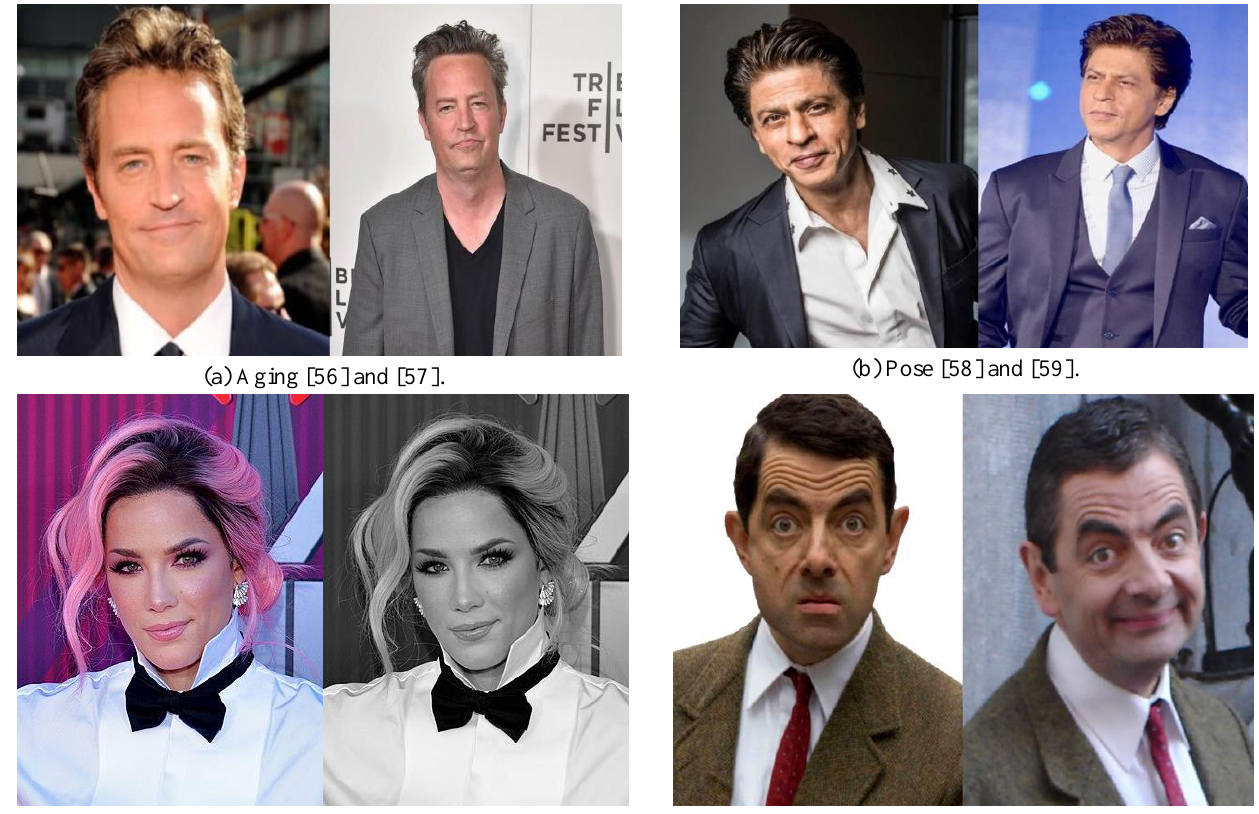
Figure 1. Variations of different